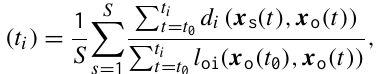
Fig. 1. Initialization and forecast of oil spill evolution phases. Dur- ing initialization the thin and thick areas and thicknesses of the slick state variables are